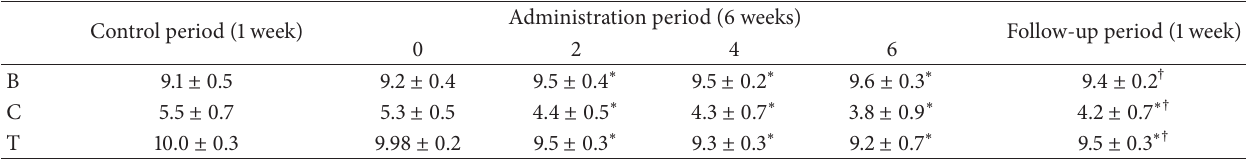
Table 2: Effects of 3-prebiotic formula administration on the fecal bacterial flora. Control period (1 week)